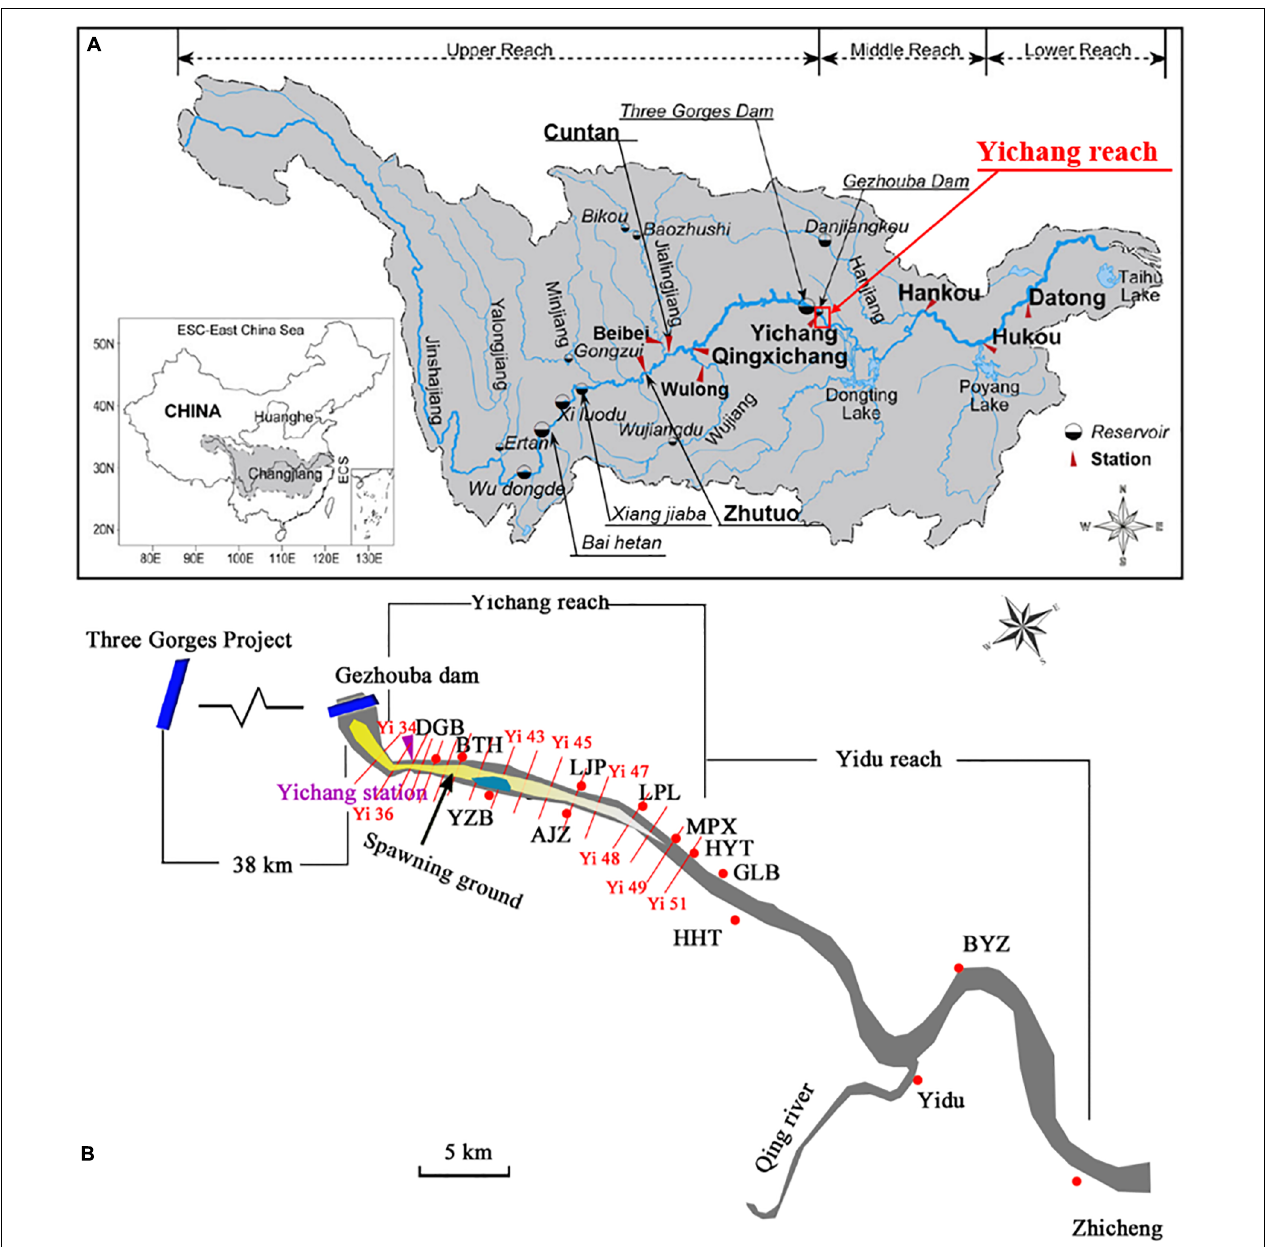
FIGURE 1 | (A) Boundaries of the Yangtze River Basin. (B) Map of the Yichang reach. The yellow area in (B) shows the spawning ground of Chinese sturgeon, and red lines indicate the cross sections from Yi34-Yi51 without Yi35. DGB, Dagong Bridge; BTH, Baotahe; YZB, Yanzhiba; AJZ, Aijiazhen; LPL, Longpan Lake; MPX, Mopanxi; HYT, Huyatan; GLB, Gulaobei; HHT,